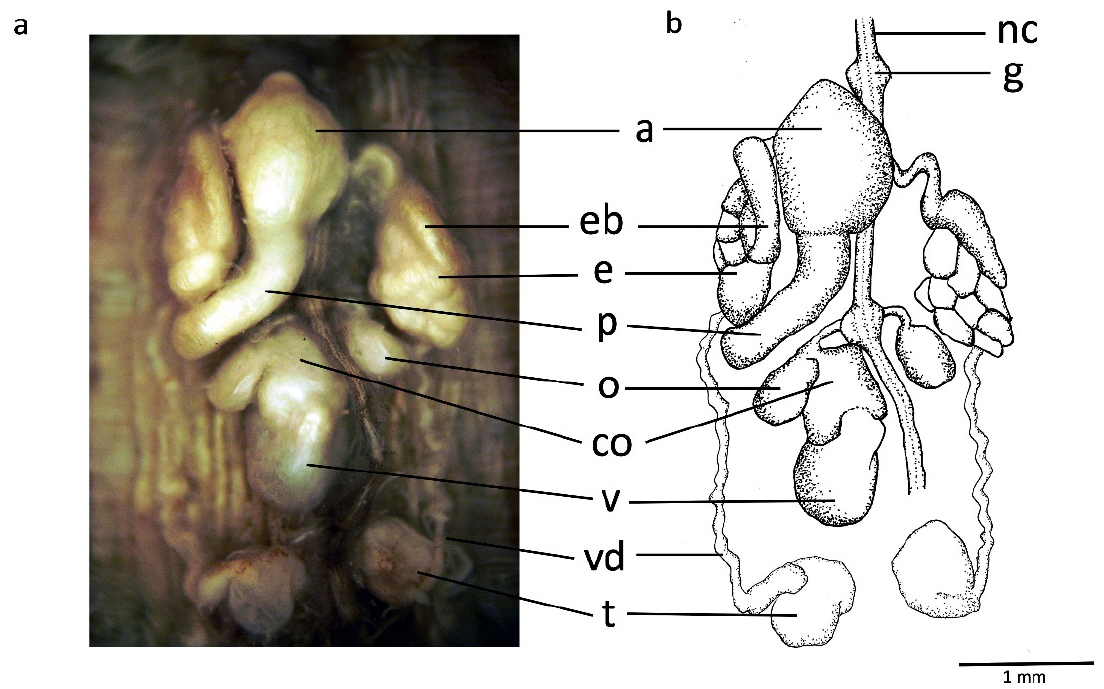
Figure 6. Hirudo verbana bilineata ssp. nov. ( a , b ) dorsal view of reproductive system of nov. a, atrium, co, common oviduct, e, epididymis, eb, ejaculatory bulb, g, ganglion in segment XI, nc, ventral nerve cord, o, ovisac, p, penis sheath, t, testisac, v, vagina, vd, vas deferens.